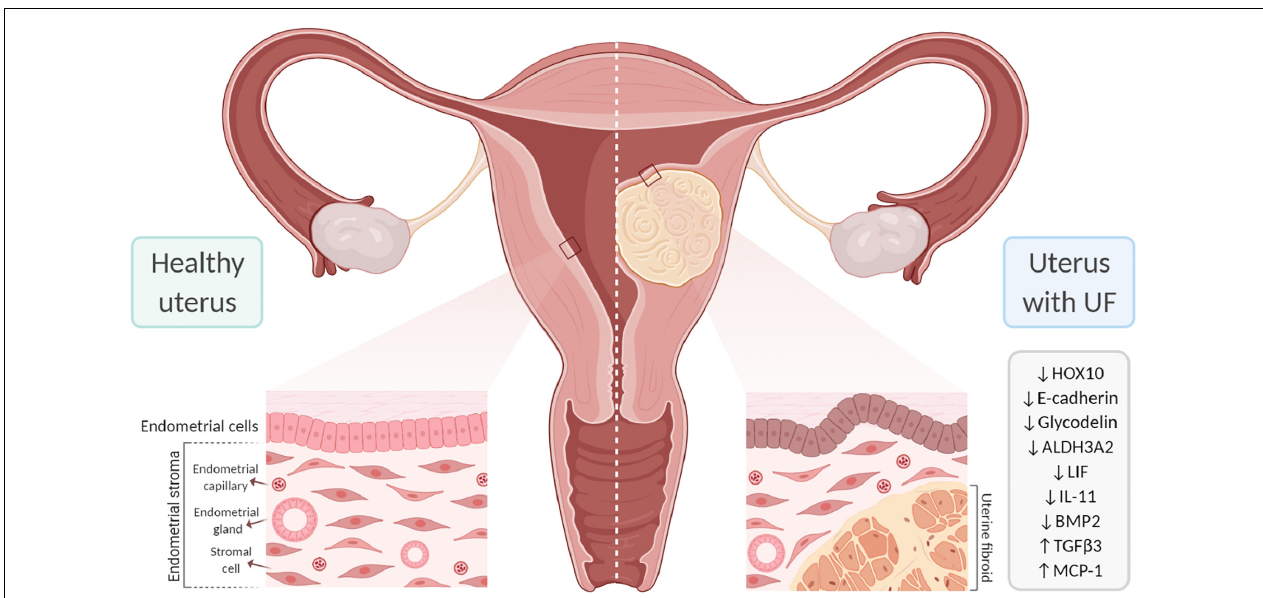
FIGURE 4 | Effect of uterine fibroids (UFs) on endometrial receptivity and implantation. The presence of UFs impacts endometrial gene expression, contributing to failure in endometrial receptivity. In addition, submucosal UFs can distort the uterine cavity, which interferes with embryo implantation and placentation, likely affecting fertility. ALDH3A2 , aldehyde dehydrogenase 3 family member 2; BMP2 , bone morphogenetic protein 2; HOX10 , homeobox gene 10; IL-11 , interleukin 11; LIF , leukemia inhibitory factor; MCP-1 , monocyte chemoattractant protein-1; TGF- β 3 , transforming growth factor beta